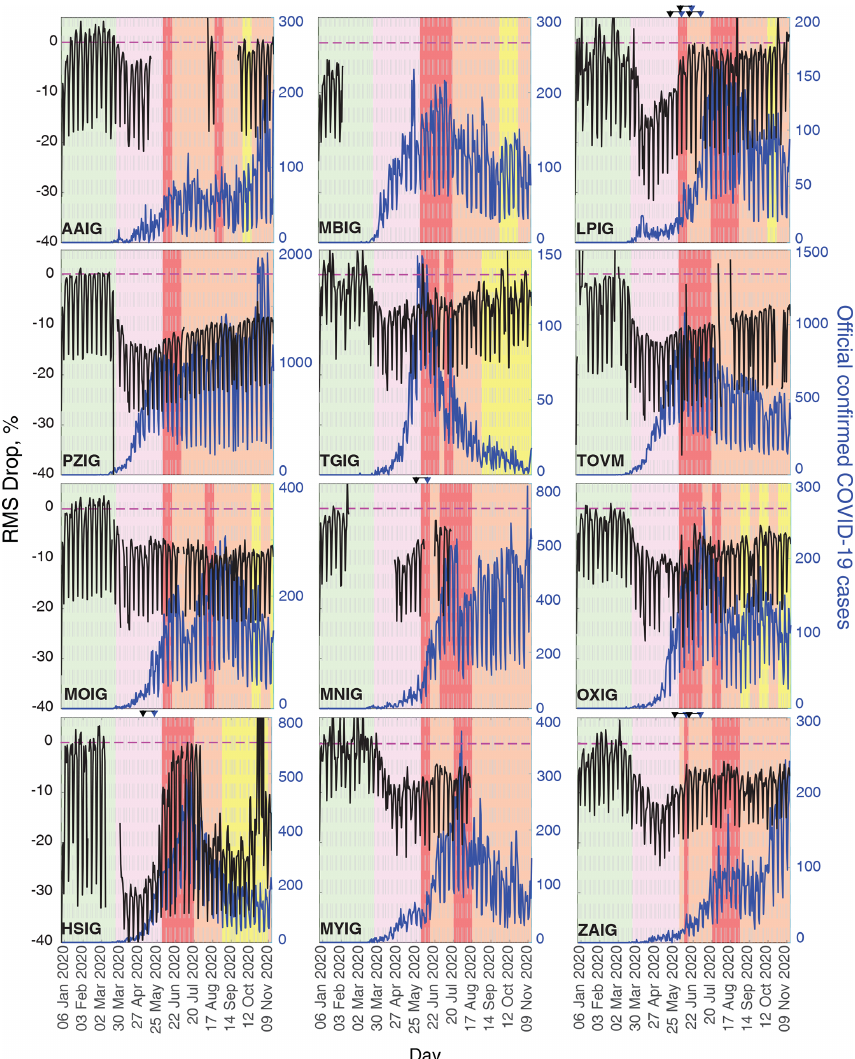
Figure 4. The rms noise for frequencies 1 to 5Hz (left axis, black lines) at stations located in capital cities. The right axis (blue line) indicates the number of officially confirmed COVID-19 cases. Triangles on top of selected stations indicate when the rms noise starts an increase tendency (black triangle) and when the COVID-19 cases start to increase quickly (blue triangle). The lag between these triangles is 2